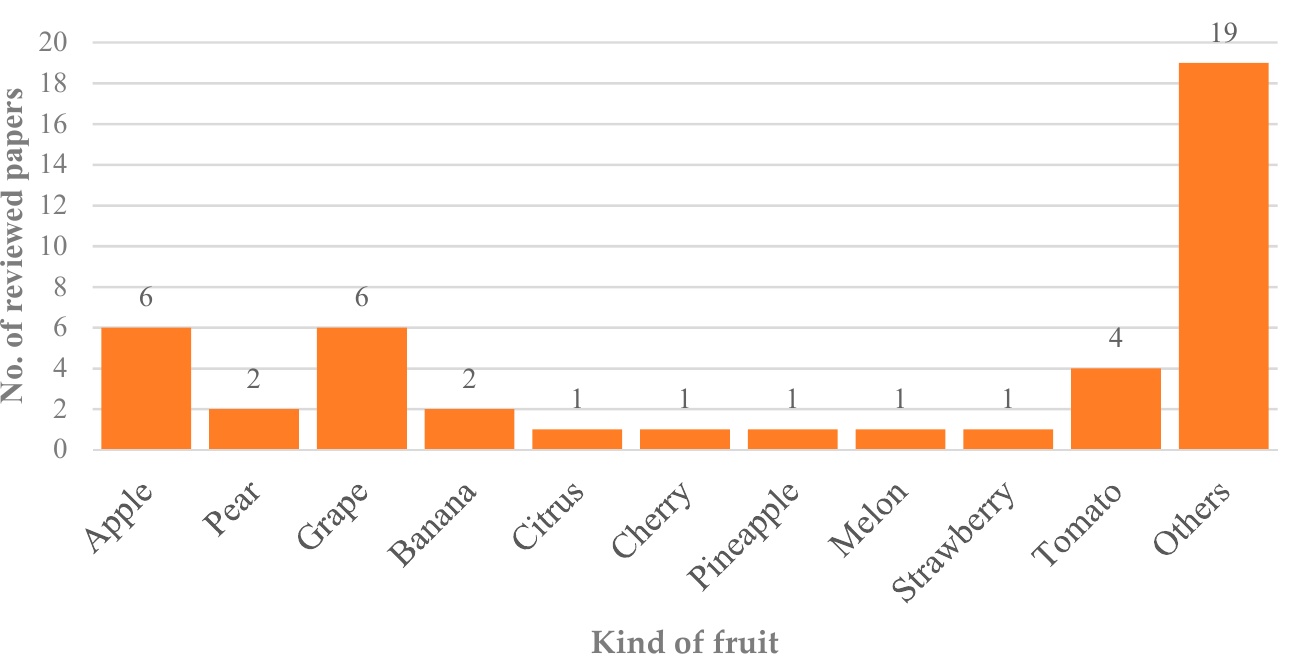
Figure 4. Number of model categories in fresh fruit supply chain optimization. It was observed that all models were based on the well-defined underlying factors such as links, actors, actions, and states. The product is characterized by two types of states: appearance and quality. Appearance states are affected by handling action while the quality states are affected by processing, transportation and storage. The models in the literature can be viewed from a robustness point of view [90]. The linear programming models include crop growth characteristics, seasonality, weather